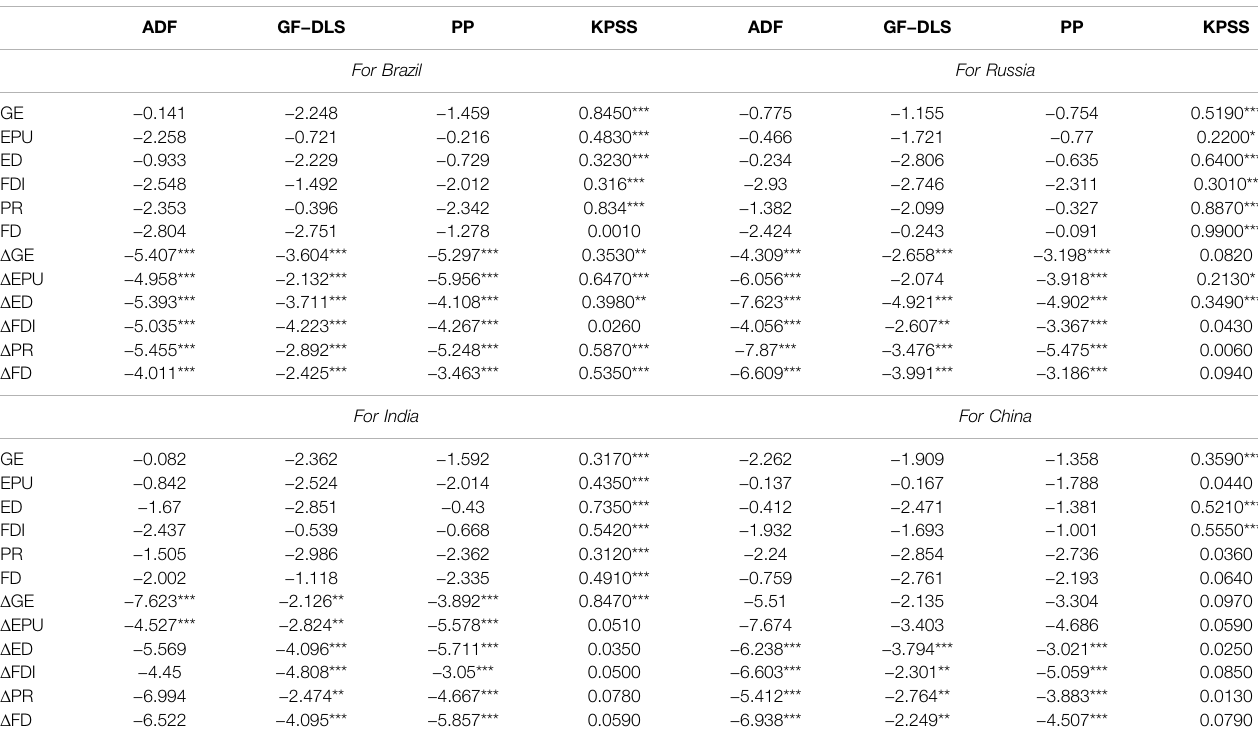
TABLE 2 | Results of Unit root